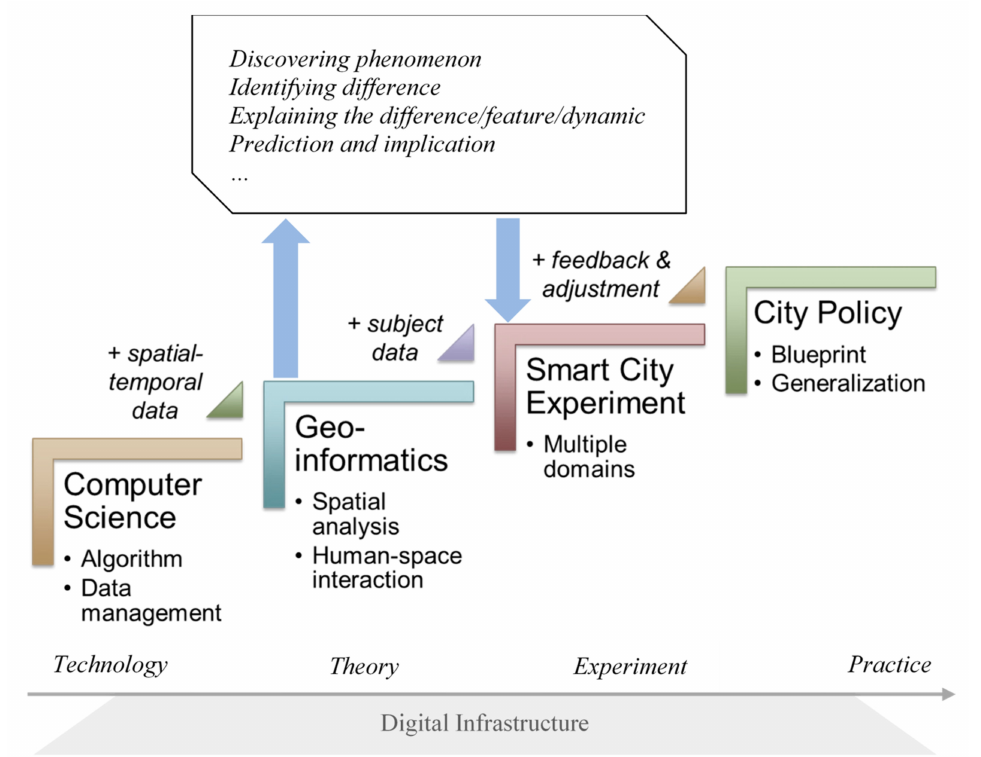
Figure 3. The role of research in linking big data and smart city